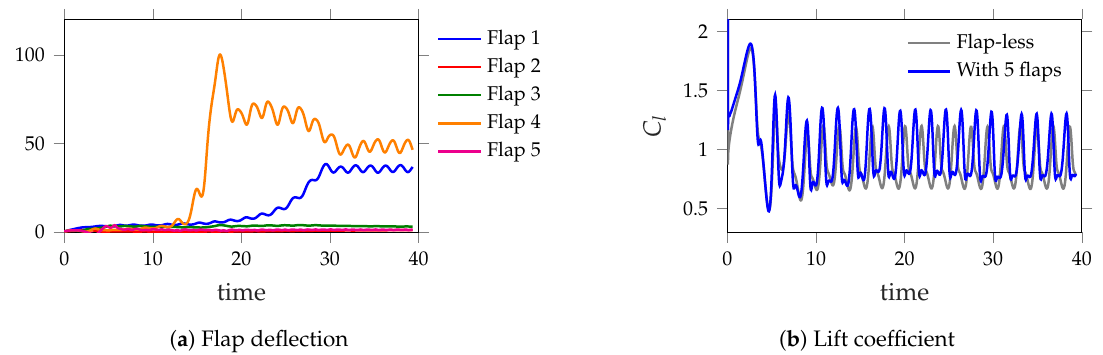
Figure 3. Plots of flap deflection, β , and lift coefficient, C l , versus dimensionless (convective) time. The lift plots provide both the flap-less case and the case of five flaps located at 0.2 c , 0.35 c , 0.5 c , 0.65 c and 0.8 c from the leading edge, k β = 0.001 and i β = 0.001.